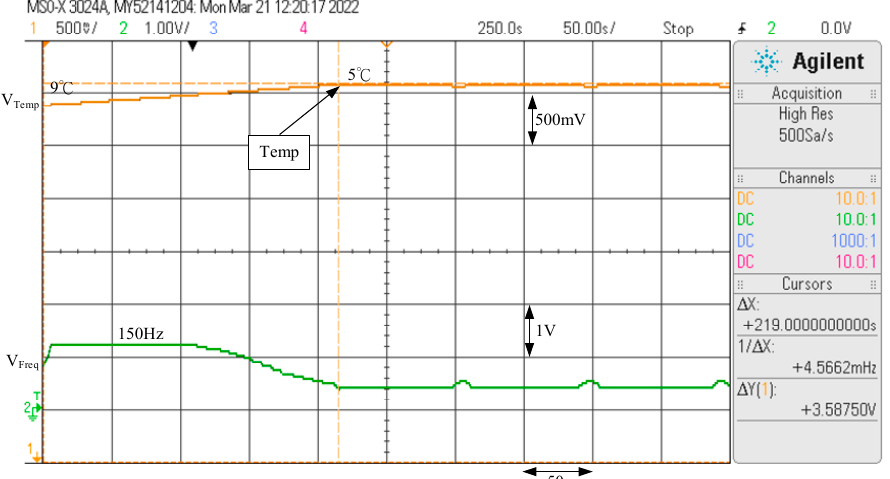
Figure 35. Response waveform of the temperature control with the proposed extension controller (control the temperature to change from 9 °C to 5 °C). Table 10. Comparison of the response speed of the temperature control under different ambient temperatures between the conventional P-I controller and the extension controller when the temperature is set to 5 °C.